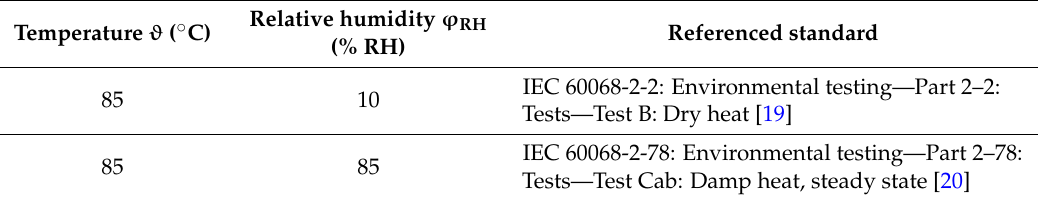
Table 2. Parameters of climate conditions and referenced